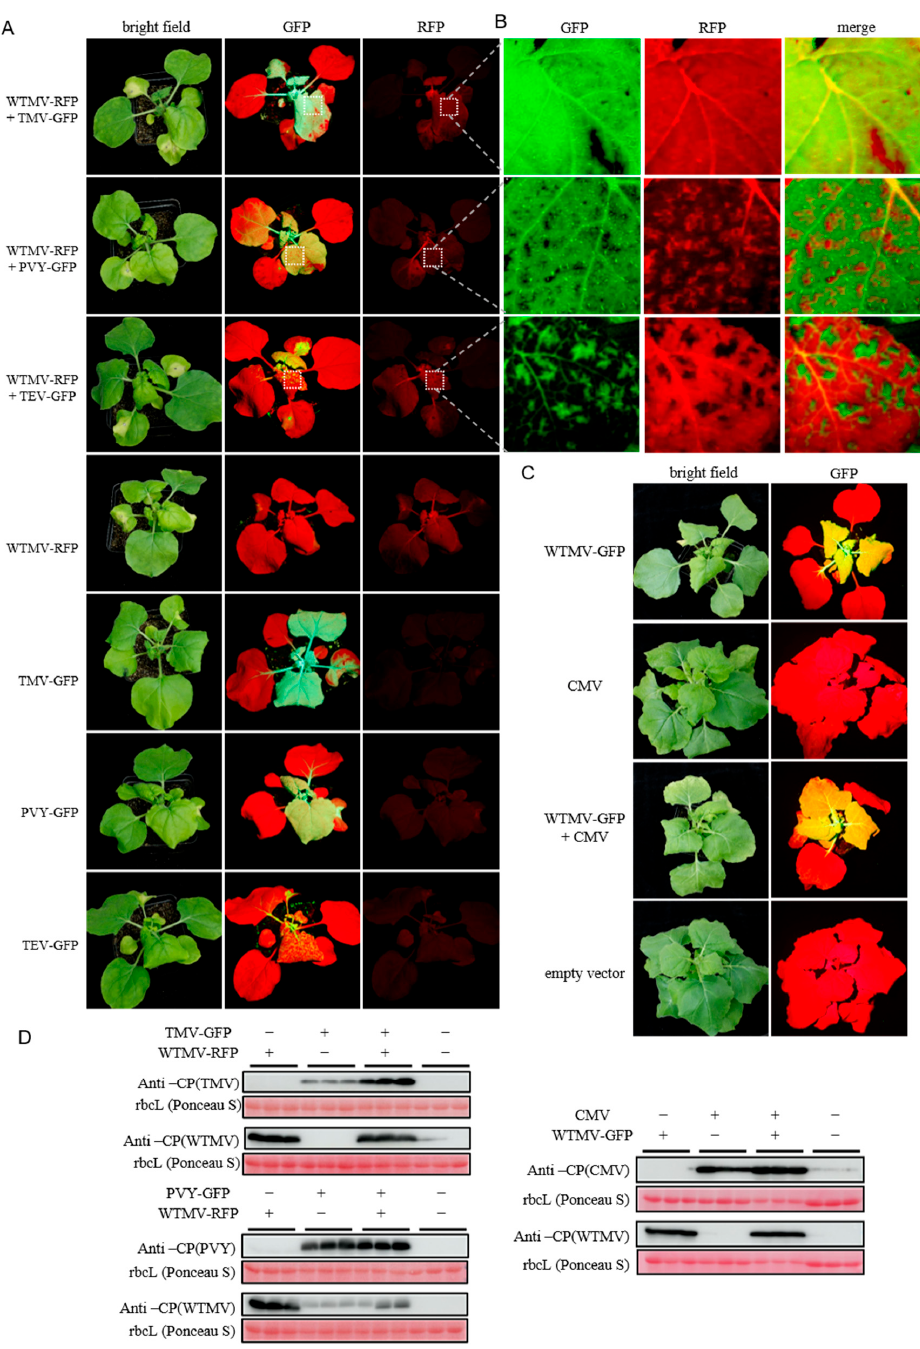
Figure 6. The coinfection of WTMV and other tobacco viruses on Nicotiana benthamiana . ( A , C ) The N. benthamiana plants are co-inoculated by agroinfiltration with different virus infectious clones. The plants infected by single viruses were used as controls. The photographs were taken 2 weeks post-infiltration. ( B ) The zoomed-in views of the leaves from panel ( A ). The green and red channels are extracted from the photographs taken with GFP and RFP filters, respectively. The contrasts are adjusted to minimize the background. ( D ) Western blotting analysis of the plants described in panels ( A , C ). The samples were obtained from the upper leaves of the plants after taking photographs. The different lanes for each treatment indicate biological repeats. Ponceau S stained rubisco large subunit (rbcL) is used as the loading